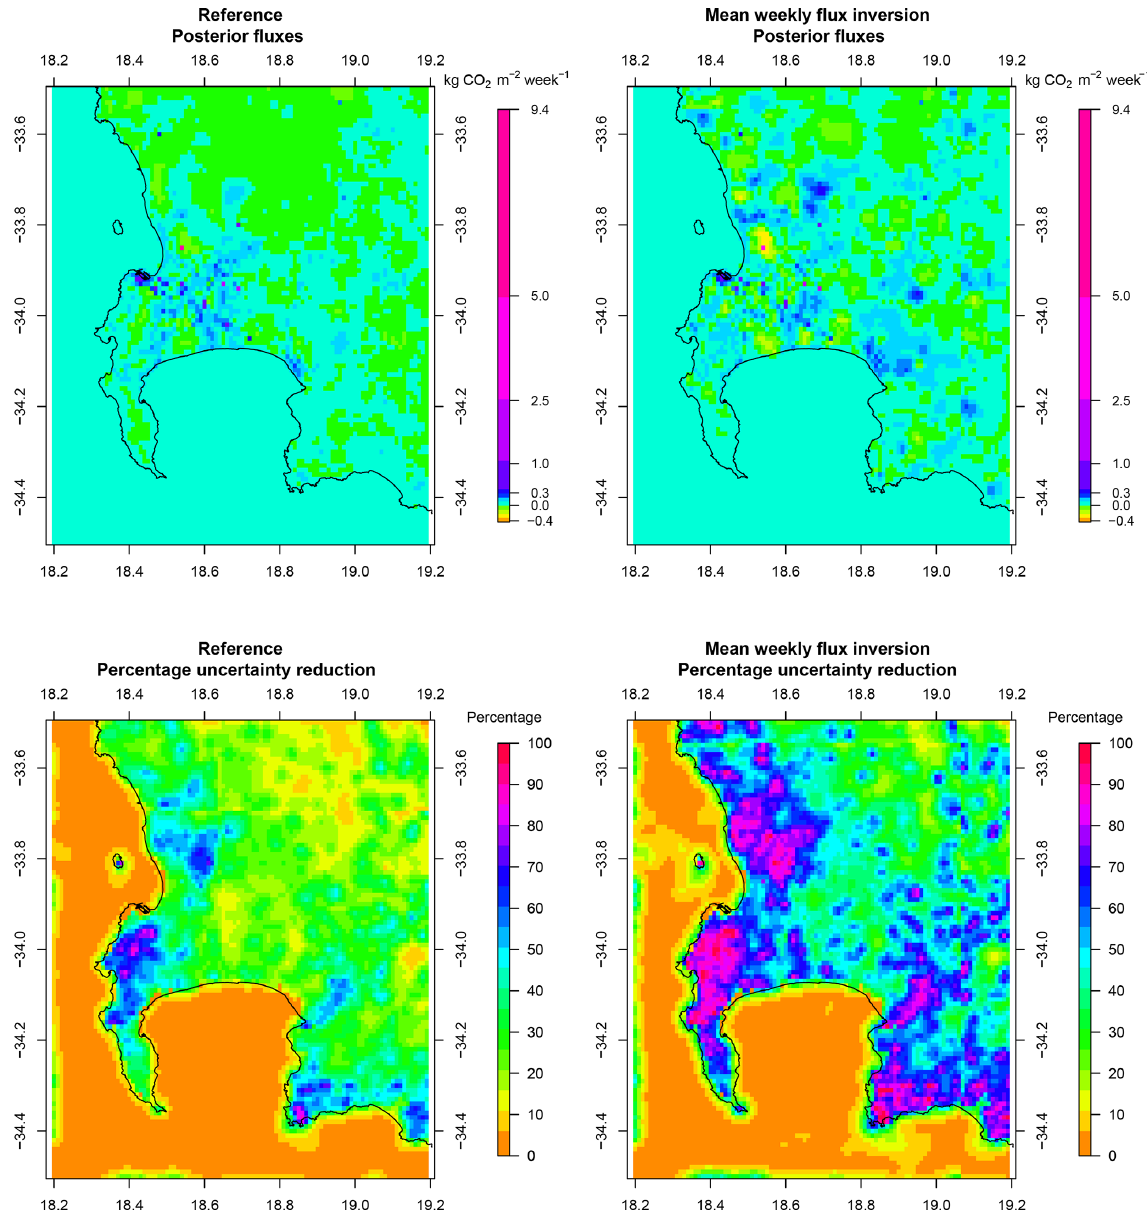
Figure 8. Spatial distribution of the posterior fluxes and uncertainty reductions achieved by the reference inversion S0 and mean monthly flux inversion S16 for September